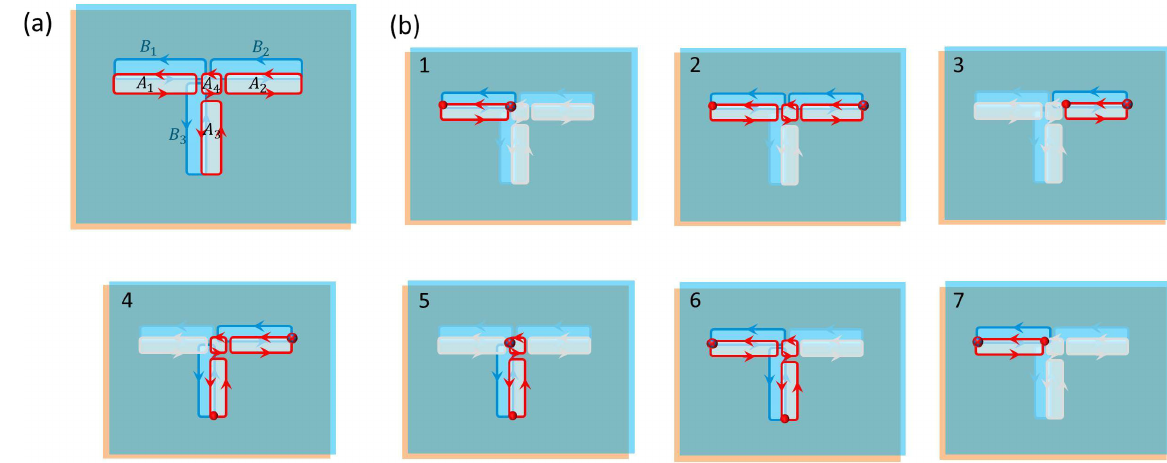
FIG. 8. (a) T -junction gate configuration that can be used to braid two nearby zero modes. There are four top gates, labeled A 1 ; … ; A 4 , and three bottom gates, labeled B 1 ; B 2 ; B 3 . (b) Protocol for braiding two zero modes, which are marked by the circles. One of them is marked with a red “ x ” in order to track its position. Gates with edge states shown in gray are turned off, those with the edge modes shown in red (top layer) or blue (bottom layer) are on. Adiabatically turning the gates on and off in the pattern shown in (1) – (7) effectively braids the zero